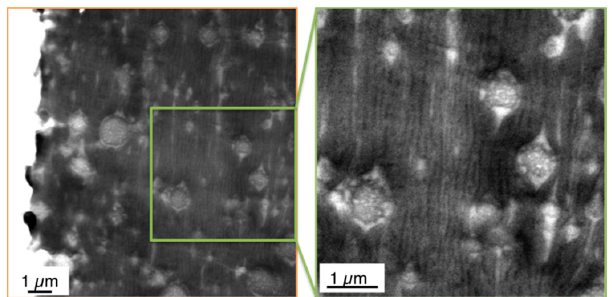
Figure 11. TEM micrograph visualizing the phase morphology in the surface (first 5 µm layer) of an injection-molded specimen made of the PC/ABS blend based on SAN with low molecular weight SAN at two different magnifications. The zoom-in picture on the right hand side shows the streak-like elongated SAN phases (which appear black at this thickness of only around 10–20 nm).